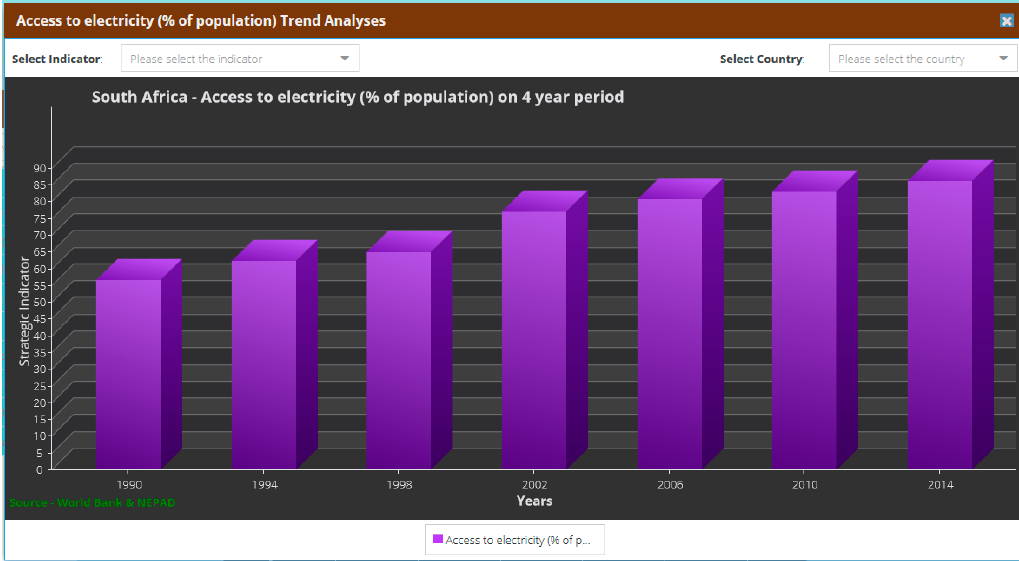
Figure 9. Charting options are provided by the front end for visual analysis. ISPRS Int. J. Geo-Inf. 2019 , 7 , x FOR PEER REVIEW